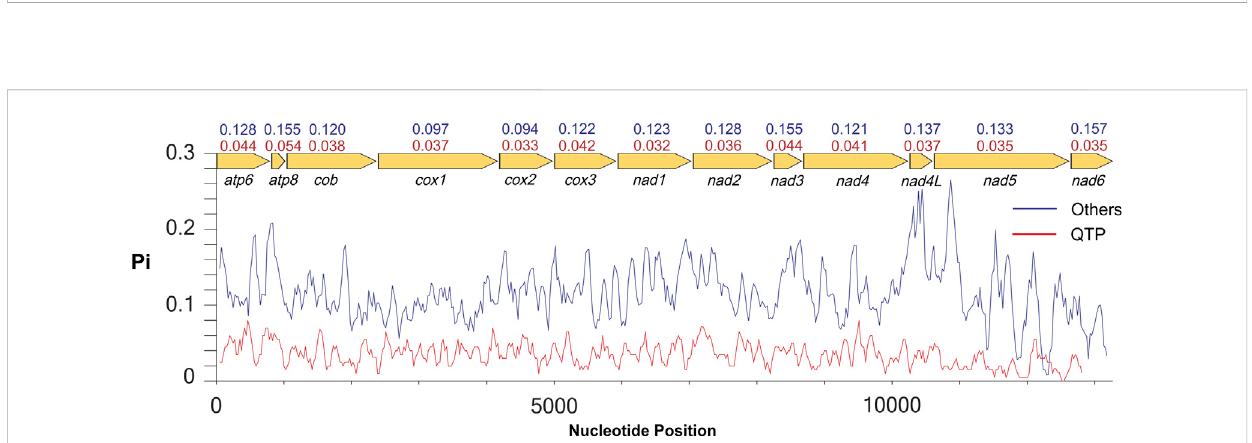
FIGURE 2 Nucleotide diversity (Pi) of 13 PCGs in 13 sequences of Lycaenidae. Lines show the values of Pi in a sliding window analysis. The red line represents theQTPspecies,andthebluelinerepresentsotherspecies.ThePivaluesforeachgroupandgeneareshownonthegenename.Redvaluesrepresentthe QTP species, and blue values represent other